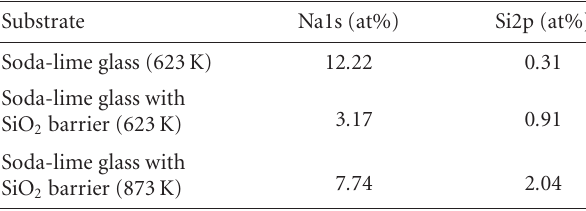
Table 1: Na and Si concentrations on the surface of annealed TiO 2 thin films, as observed with